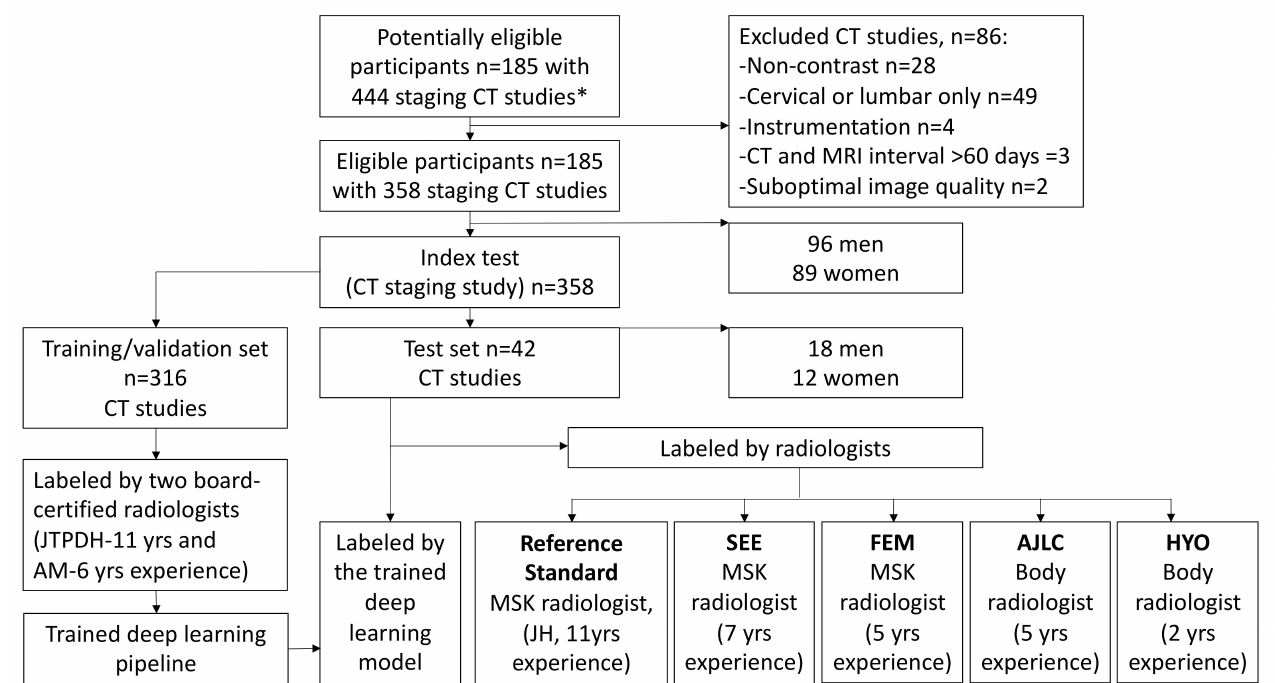
Figure 4. Flow chart of the overall study design and deep learning model development. The model performance was compared with a specialist radiologist (reference standard) and four radiologists.